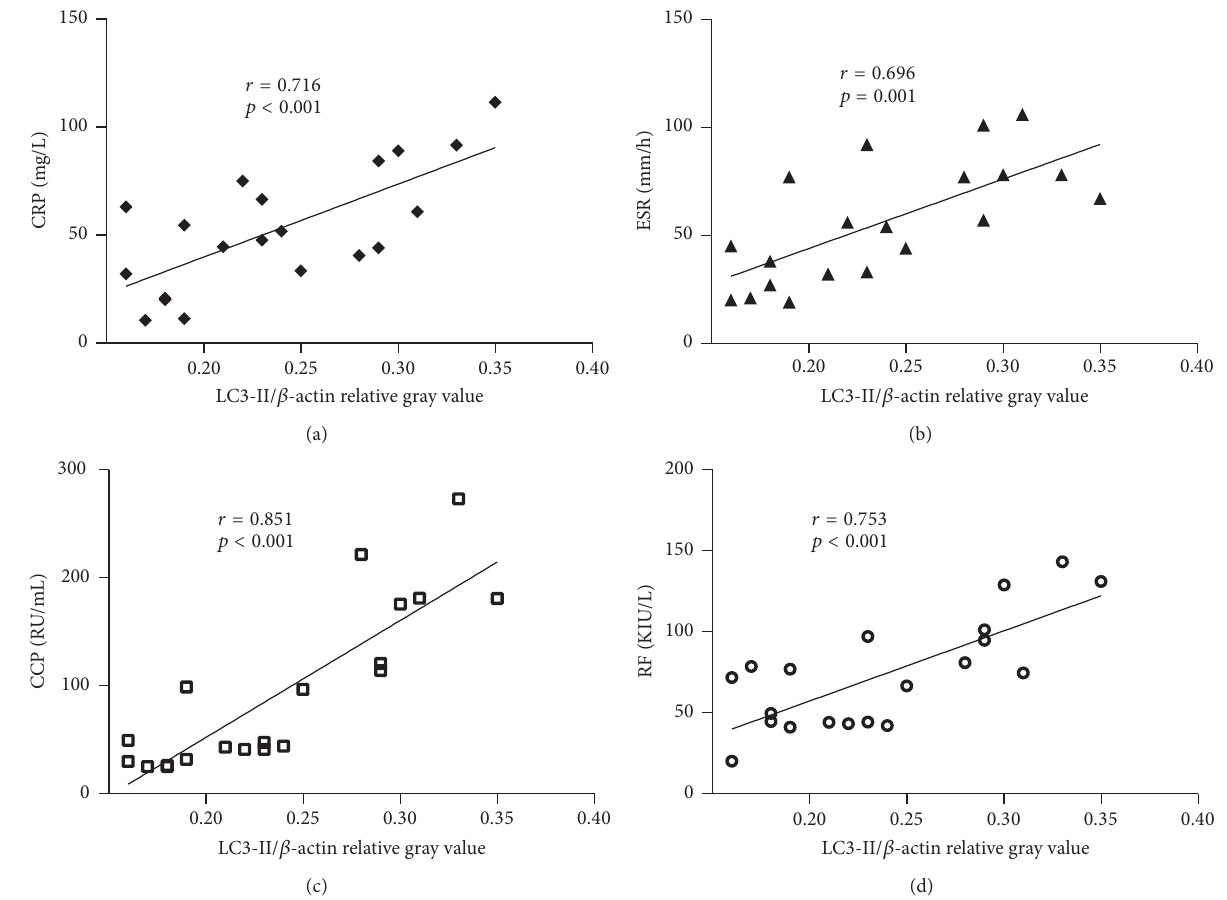
Figure 4: Correlation between the LC3-II/ 𝛽 -actin relative gray value and disease activity parameters in RA patients. The correlation between the LC3-II/ 𝛽 -actin relative gray value and the serum CRP level (a), ESR level (b), serum CCP level (c), or serum RF level (d). 𝑛 = 20 ; 𝑝 < 0.05 is considered statistically